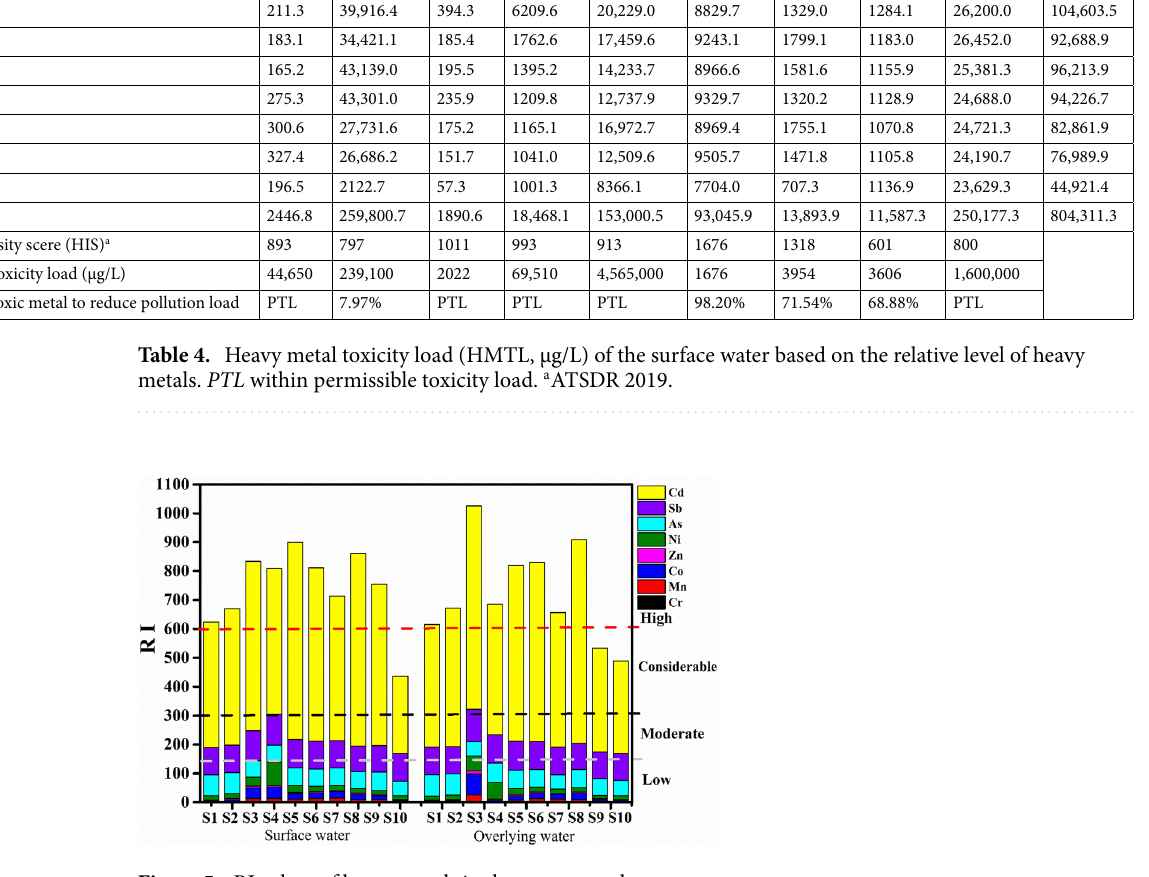
Figure 5. RI values of heavy metals in the water